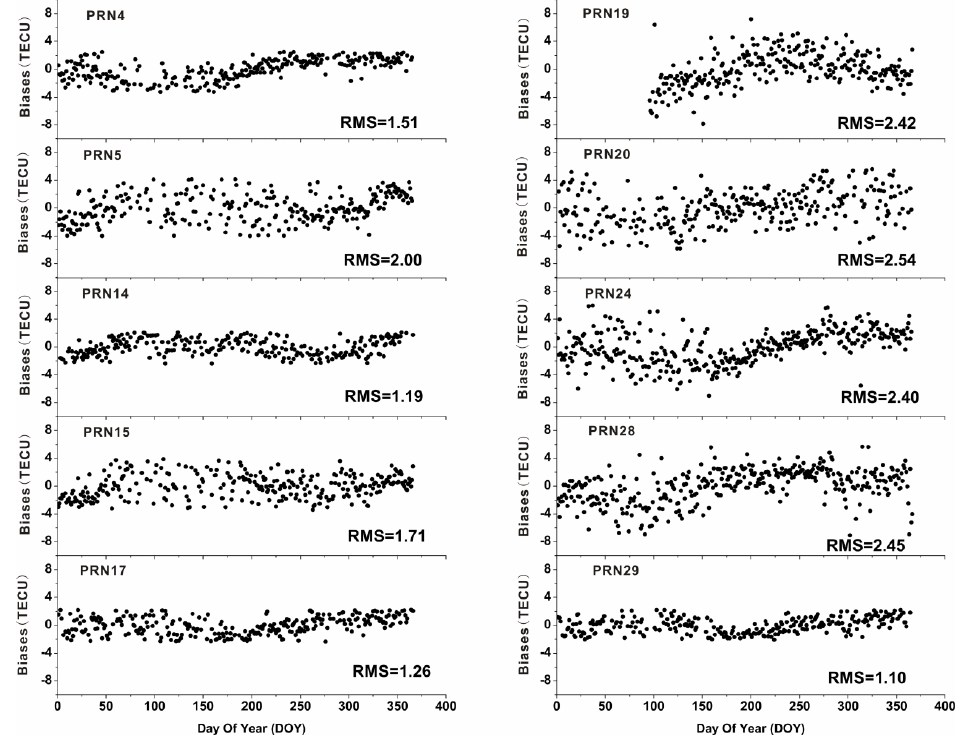
Fig. 3. Satellite instrumental biases estimated from GPS data observed at XIAM station in 2004 (relative to the mean